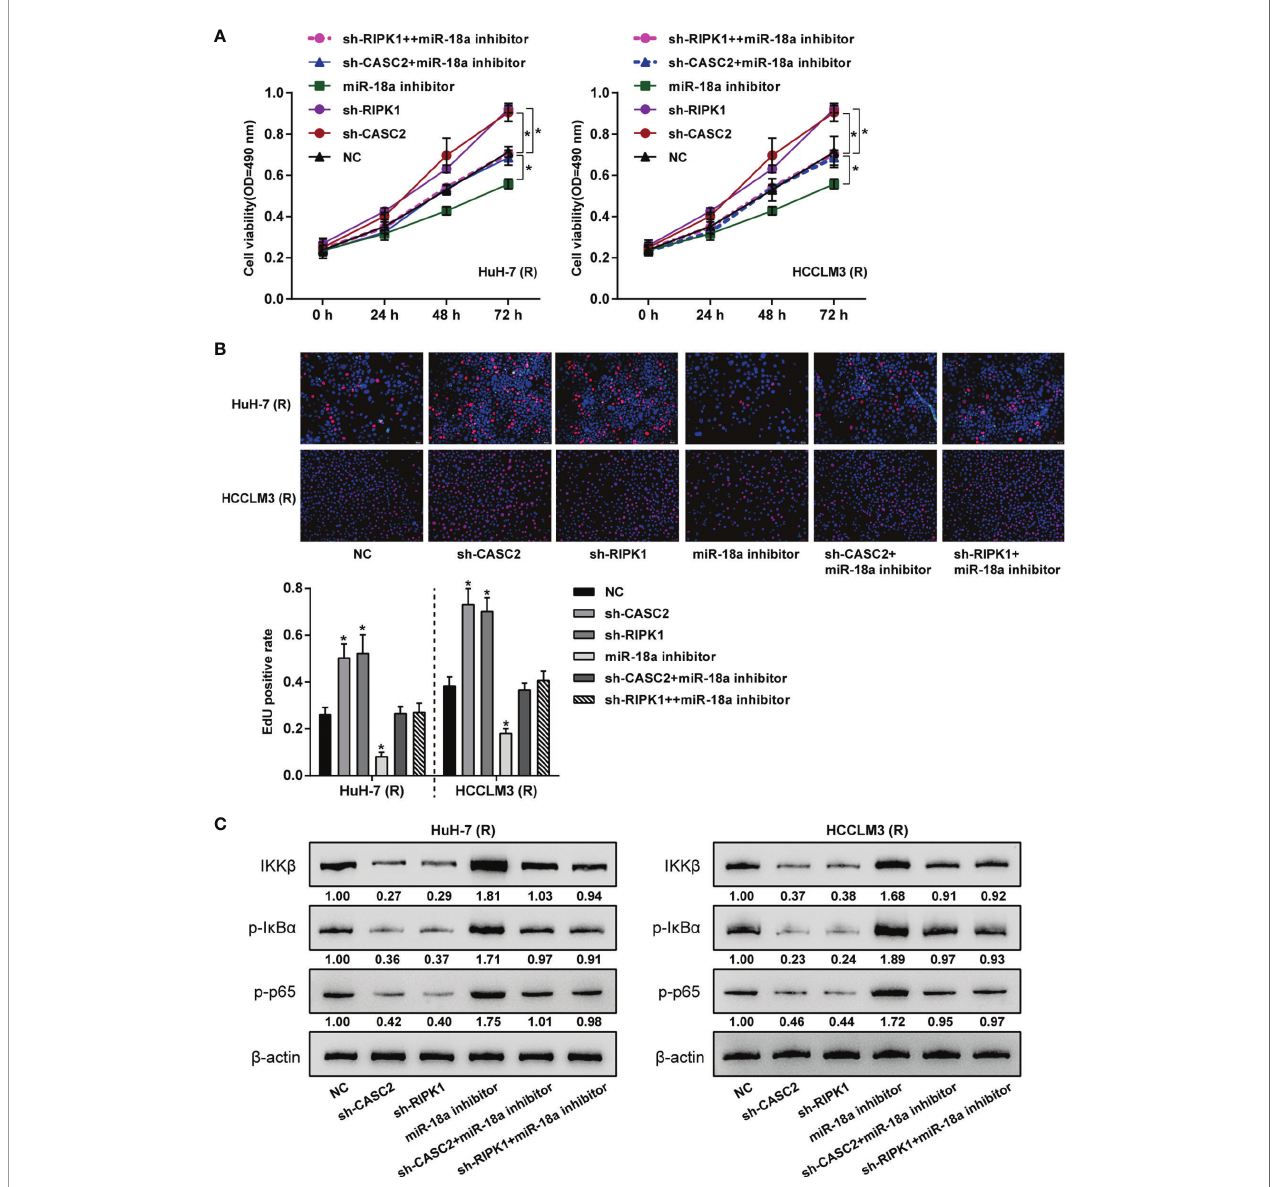
FIGURE 7 | Dynamic effects of the CASC2/miR-18a/RIPK1 axis on TRAIL-resistant HCC cell proliferation. Huh-7 (R) and HCCLM3 (R) cells were divided into six groups: NC, sh-CASC2, sh-RIPK1, miR-18a inhibitor, sh-CASC2+ miR-18a inhibitor, and sh-RIPK1+ miR-18a inhibitor; cells in different groups were transfected accordingly and examined for cell viability using CCK-8 assay (A) ; DNA synthesusing EdU assay (B) ; the protein levels of IKK b , p-I k B a , and p-p65 using Immunoblotting (C) . *p < 0.05 compared with NC